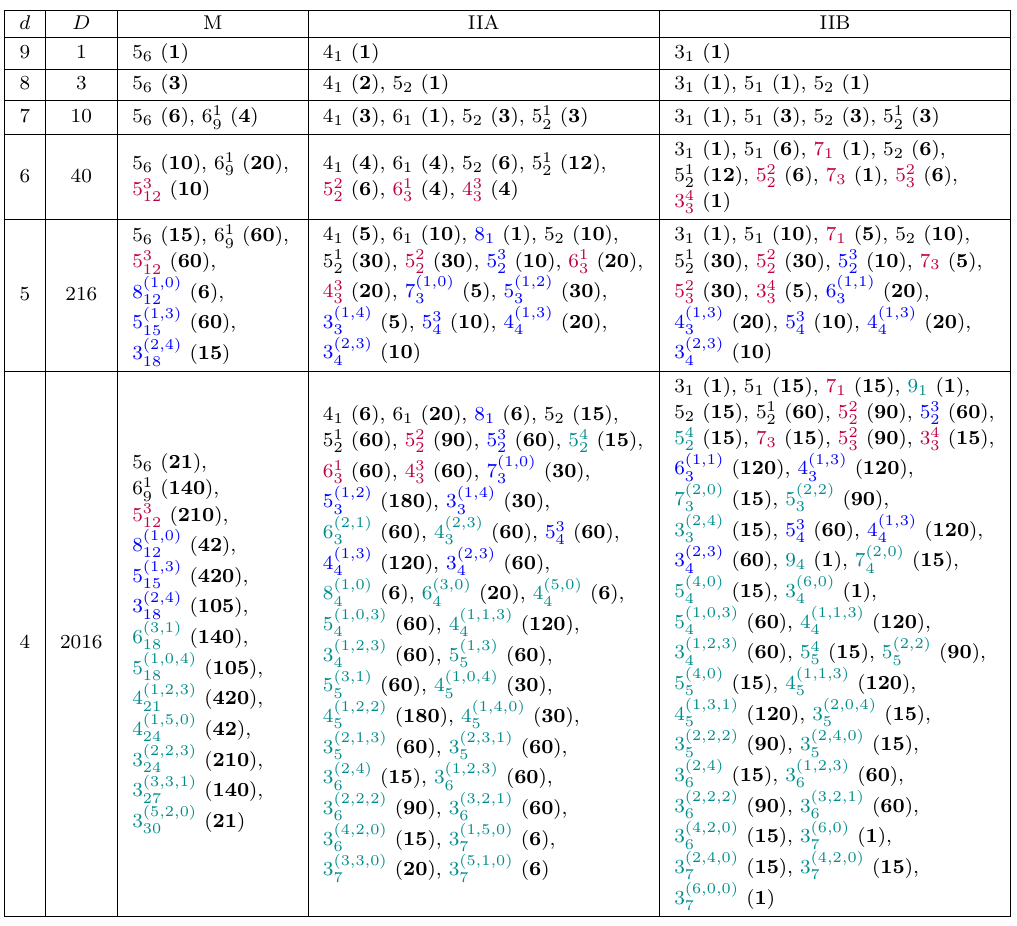
Table 10 . Branes in the 3-brane